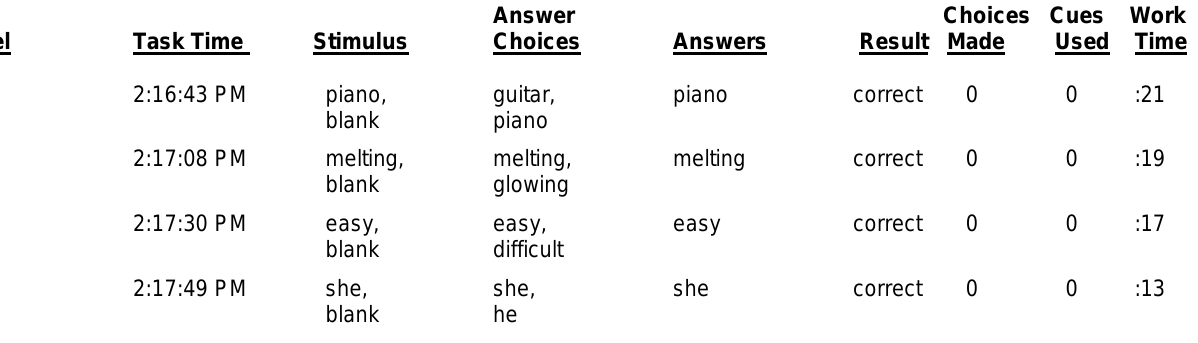
8A. User Activity Data in Automatically Generated